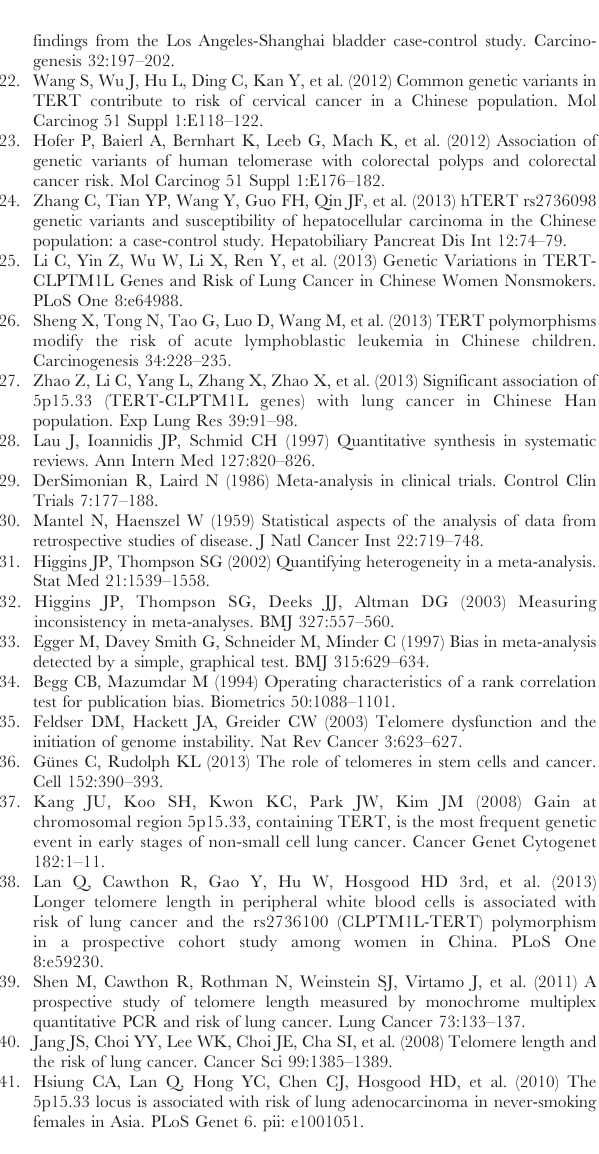
Figure S1 Flow diagram of the study selection proce- dure. Figure S2 Begg’s funnel plot for publication bias (AA vs. GG). Figure S3 Begg’s funnel plot for publication bias (recessive